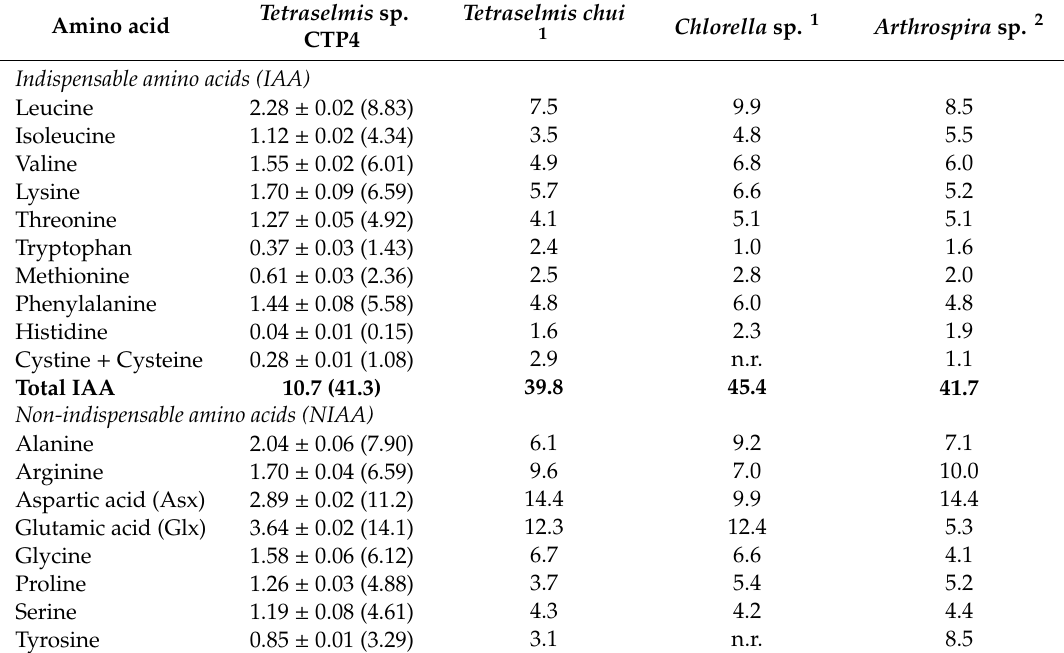
Table 2. Amino acid concentration (g / 100 g DW) of Tetraselmis sp. CTP4 grown semi-continuously in industrial tubular photobioreactors. Values represent the mean and corresponding standard deviation ( n = 3). Values in brackets represent the % of total amino acid. Values from the literature for Tetraselmis chui , Chlorella sp. and Arthrospira sp. are also presented in % of total amino acid. n.r.—not reported. Tetraselmis Amino acid